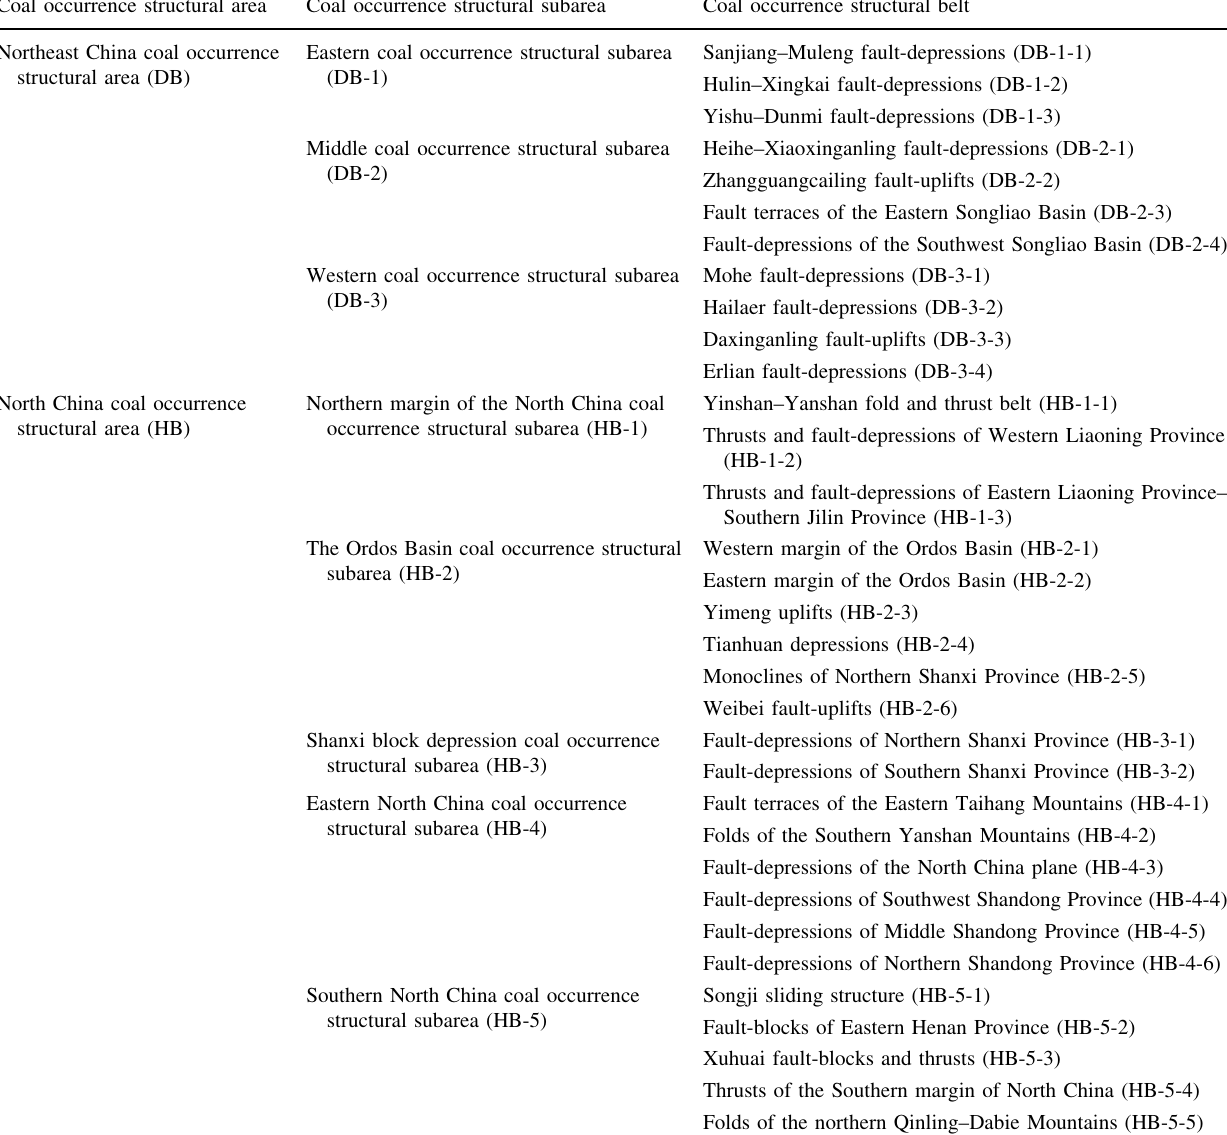
Table 1 Division of the coal occurrence structural units in